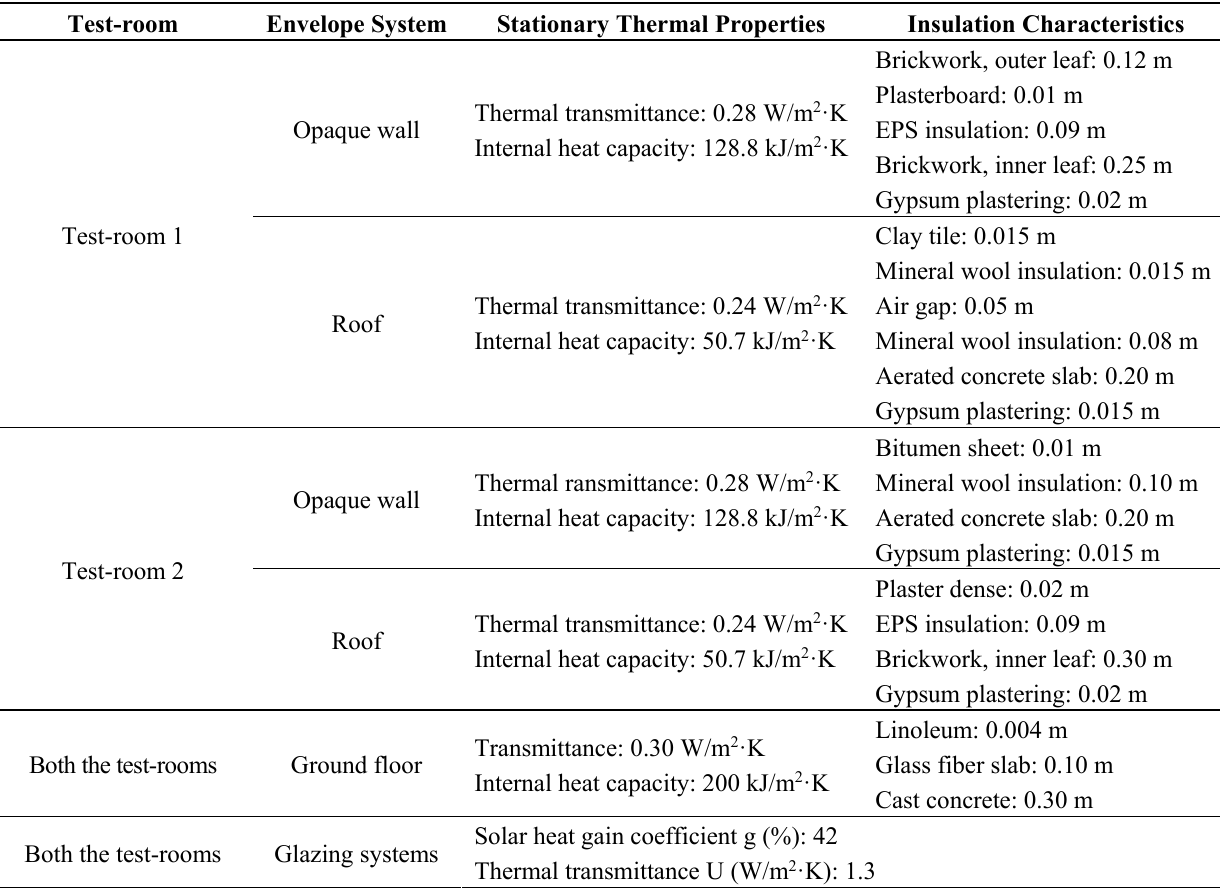
Table 2. Thermal characteristics of test-rooms’